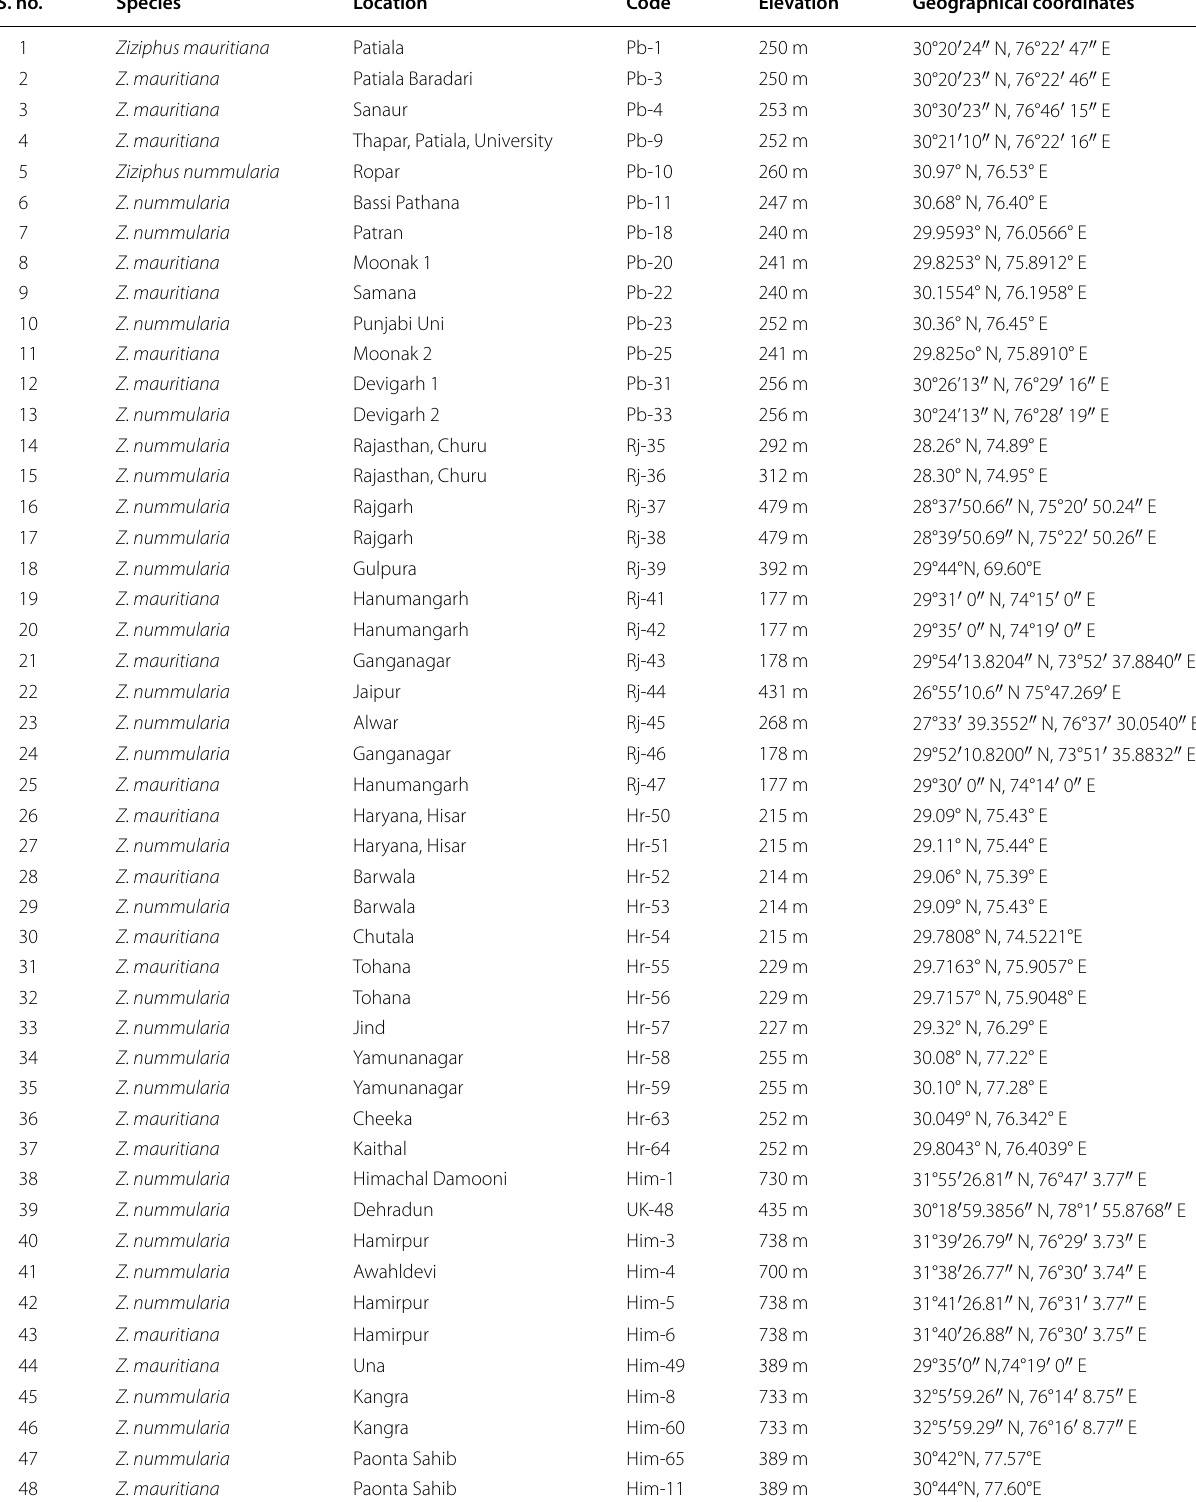
Table 1 Details of forty-eight accessions of two species analyzed in the present study S.